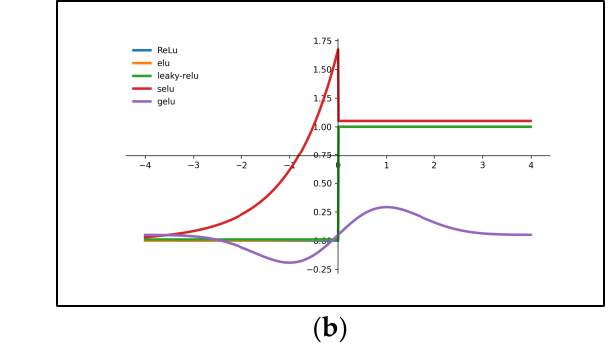
( b ) Figure 15. Errors of different activation functions in the training set ( a ) and test set ( b ). 6.5. Optimization of Algorithm After determining the feature curves, network and loss function, we needed an algo- rithm to search for the best possible parameter to minimize the loss function. The popu- larly used neural network optimization algorithm is the gradient descent algorithm. In each training step, a small amount of disturbance is made to each parameter, and the pa- rameters are updated only when the loss of the training set is reduced. Most deep learning models do not have analytic solutions. Thus, we can only reduce the value of the loss function as much as possible by optimizing the model parameters with finite iterations.